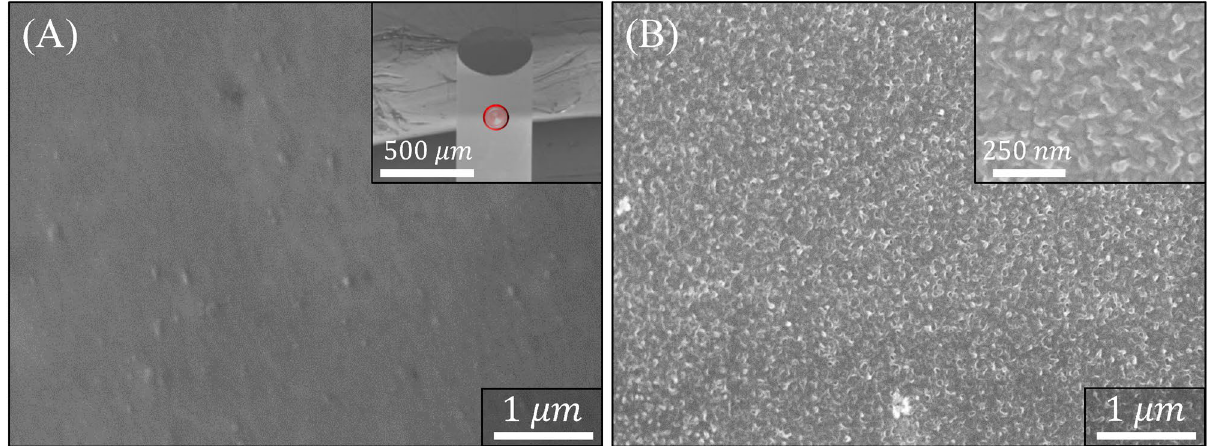
Figure 4. FE-SEM micrographs of the Pt-coated FO-SPR surface before ( A ) and after ( B ) PANI electroless deposition for 6 h at 25 °C. The inset of ( A ) low-magnification SEM image of the FO-SPR sensor tip where the red mark denotes the area where the higher-magnification SEM images ( A , B ) were captured; The inset of ( B ) corresponding closed-up magnification SEM image of the PANI/Pt-coated FO-SPR sensor surface. For SEM observations, the conductivity of the PANI film was slightly enhanced by protonating it for 10 min in a 1 M HCl solution. Processed using PowerPoint 2016 (Microsoft Office 2016), https:// www. micro soft.